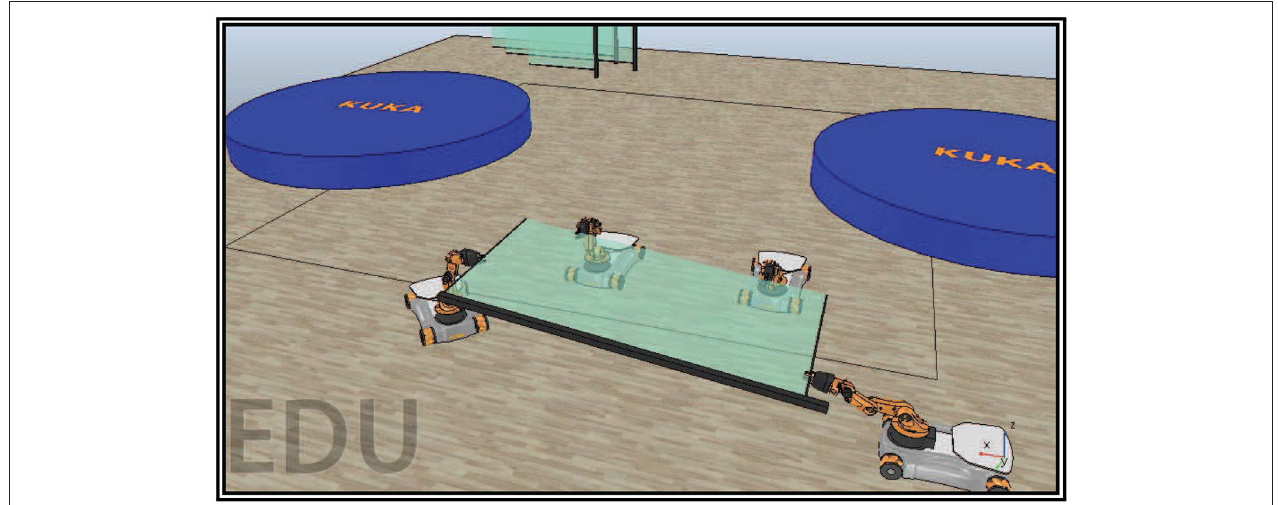
FIGURE 1 | Four mobile manipulators handling a rigidly grasped object in a constrained workspace with static